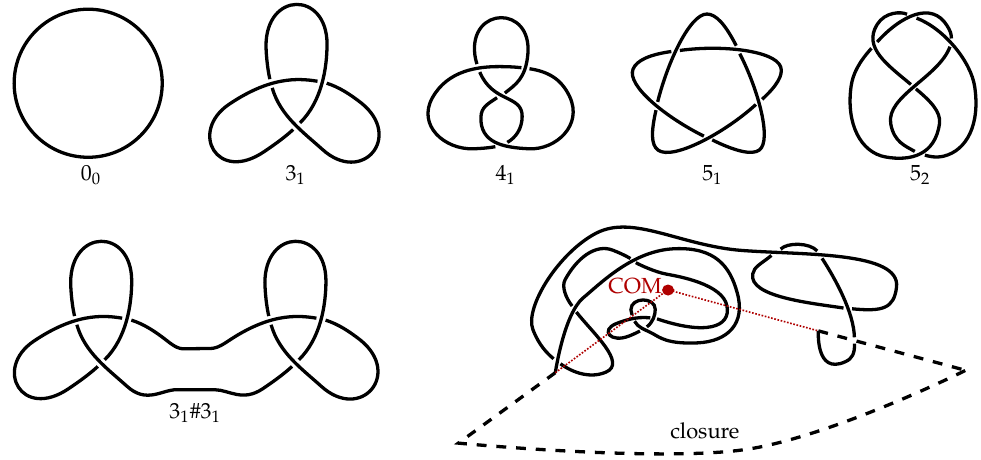
Figure 3. Schematic drawings of the five simplest knots (0 0 , 3 1 , 4 1 , 5 1 , 5 2 ) and an example of a composite knot (3 1 #3 1 , containing two 3 1 knots). On the lower right, the closure mechanism is drawn schematically. The ends of the chains are projected outward from the center of mass (COM). The chain is then closed far away from the chain by a large